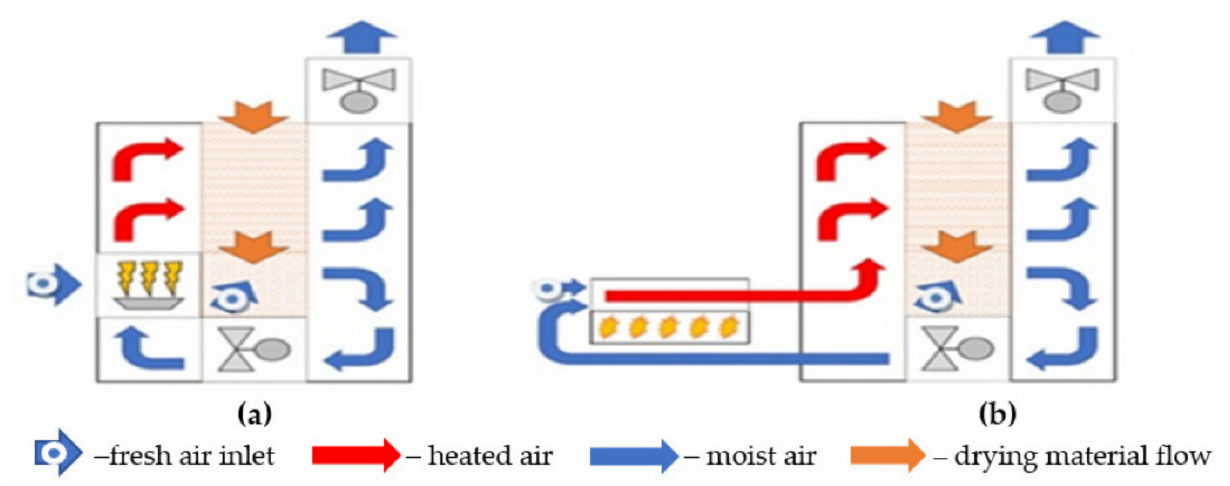
Figure 1. Dryer diagram: ( a ) S428.CS; ( b )